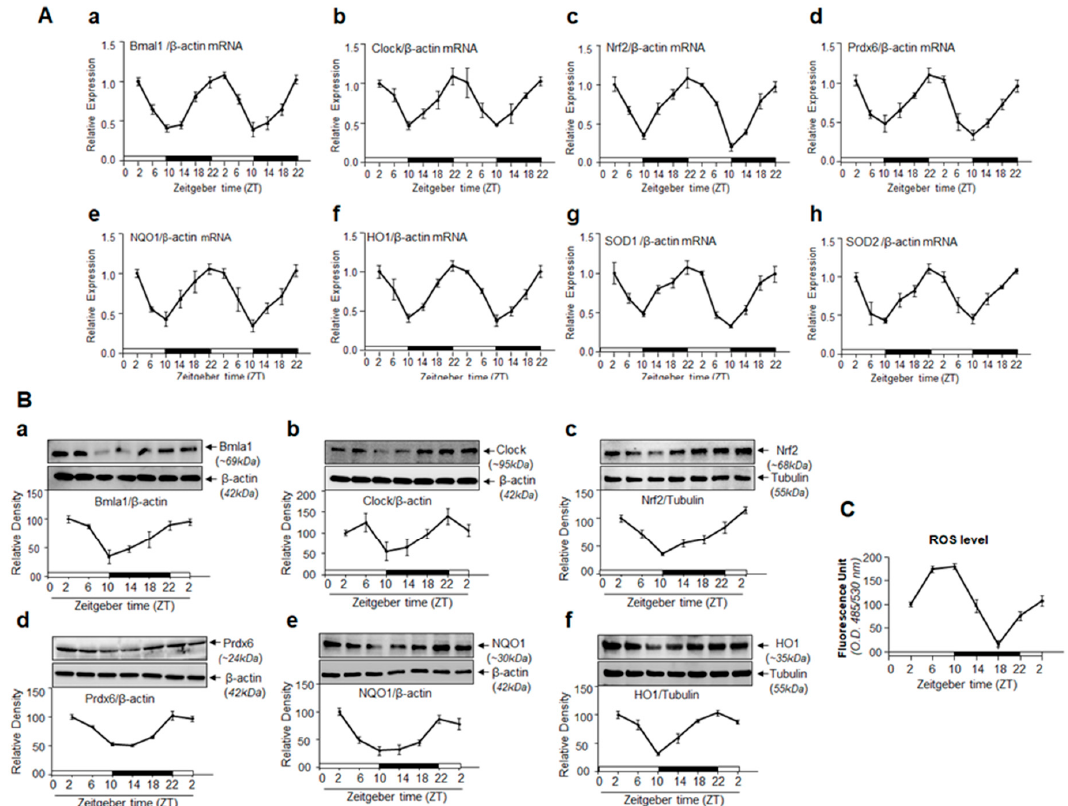
Figure 9. Rhythmic expression of Clock and Nrf2 antioxidant genes at transcriptional and translational level in C57BL/6 mice in vivo and ROS levels under 12L: 12D condition. ( A ) Regulation of clock ‐ controlled antioxidants mRNA expression in eye lenses at different Zeitgeber times (ZT). C57BL/6 mouse eye lens were harvested at 4 h intervals over the course of 48 ‐ h period, as indicated, and transcript levels were analyzed by using RT ‐ qPCR. Bmal1 and antioxidants of Nrf2/ARE ‐ mediated genes mRNA expression were examined at the indicated ZT. The data represent the mean ± S.D. from three independent experiments. ( B ) Circadian oscillation of clock and Nrf2 antioxidant targets protein, Bmal1, Clock, Nrf2, Prdx6, NQO1, and HO1 in vivo . C57BL/6 mouse eye lens were harvested at 4 h intervals over the course of 24 h, as indicated, and total protein were isolated and equal amount of protein were immunoblotted with antibodies as indicated. Circadian profiles for Bmal1, Clock, Nrf2, Prdx6, NQO1 ,and HO1 assayed by immunoblotting from C57BL/6 mouse eye lens. Protein blots were quantified using densitometer, and levels were normalized to corresponding β‐ actin and tubulin levels; lined graph below shows the protein bands. ( C ) Circadian clock controls of ROS at ZT interval. C57BL/6 mouse eye lens were harvested at 4 ‐ h intervals over the course of 24 h, as indicated, and lens homogenate prepared as described in Materials and Methods. ROS levels were measured using fluorescent dye H2 ‐ DCF ‐ DA dye methods. Data represent means ± S.D. of three independent experiments.